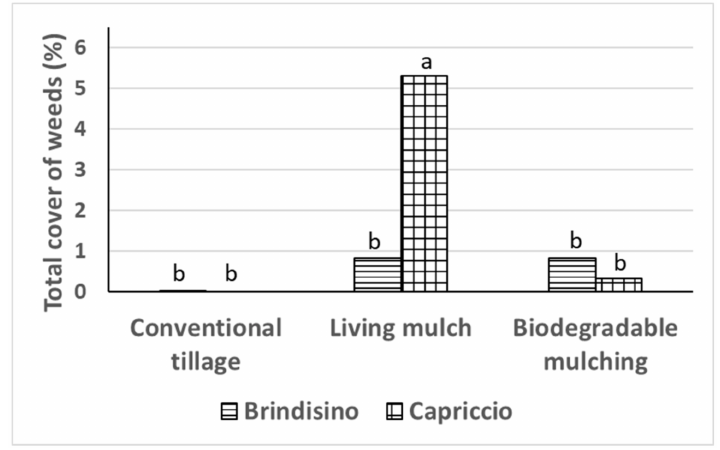
Figure 2. Effects of soil management practices and genotypes on total cover of weeds surveyed in April. Different letters indicate significant differences.